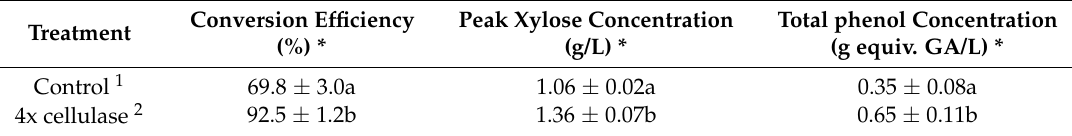
Table 5. Effect of cellulase dose on conversion, peak xylose concentrations and total polyphenol concentrations after